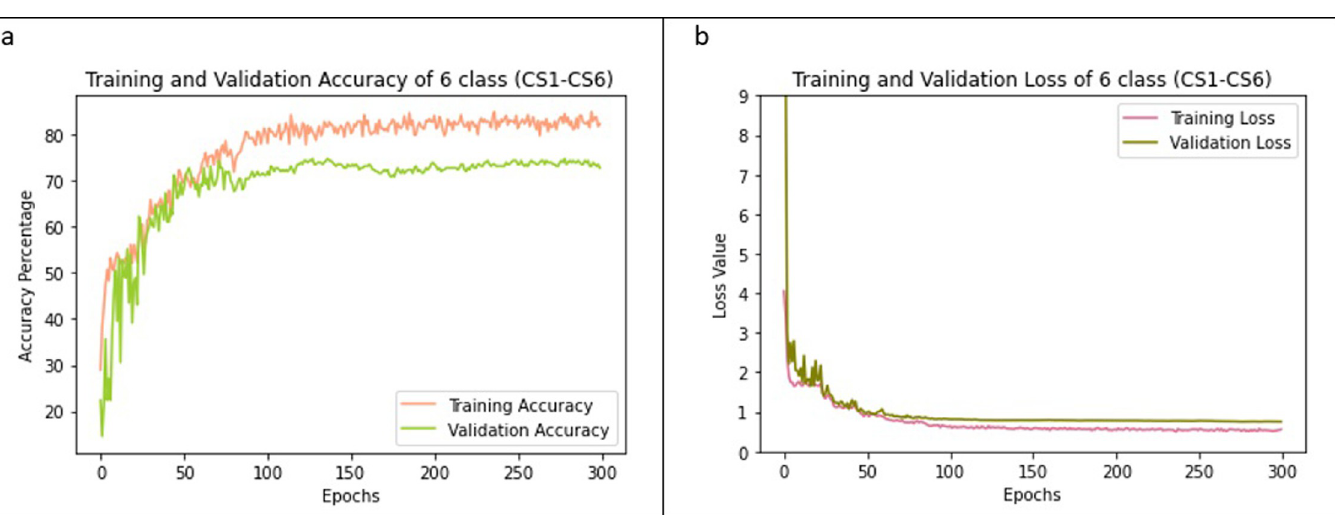
PLOS ONE | https://doi.org/10.1371/journal.pone.0269198 July 1,